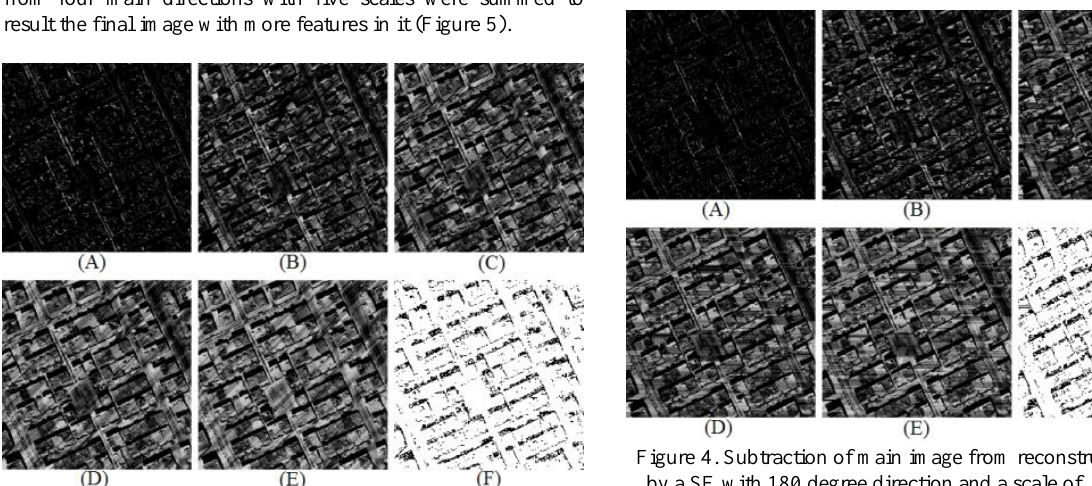
Figure 3. Subtraction of main image from reconstructed image by a SE with 135 degree direction and a scale of, A. 5×5, B.